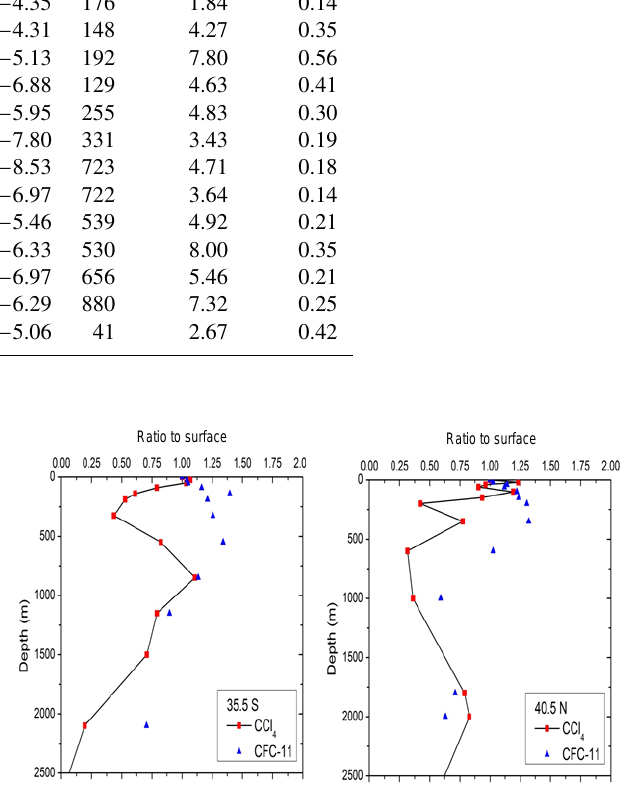
Figure 6. Depth profiles of the concentrations of CCl 4 and CFC- 11, normalized to the surface value, strongly suggest consumption of CCl 4 in intermediate waters. If there were no in situ consumption and the distributions entirely a function of mixing and transport, the curves would be similar if not identical. Plots shown are from the Atlantic